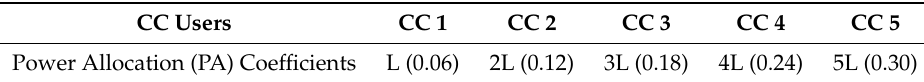
Table 1. Proposed Dynamic Power Allocation